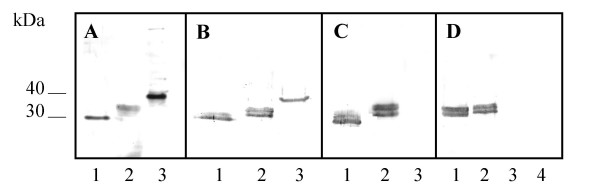
Western blots of 10% slab gels loaded with Hwp1 antigens of C. albicans stained with silver stain (panel A), an anti-Myc monoclonal antibody (panel B, lane 1), an anti-HSV monoclonal antibody (panel B, lanes 2 and 3), a polyclonal antiserum against the purified recombinant N-Hwp1 fragment (panel C) and human sera (panel D). Gels in panels A-C were loaded with rHwp1N13KV-c~myc (lane 1), N-Hwp1 (lane 2) and int-Hwp (lane 3). Panel D shows the reactivity of N-Hwp1 with sera from two patients with invasive candidiasis (lanes 1 and 2) and from two patients without invasive candidiasis (lanes 3 and 4). Molecular masses (in kDa) of standard proteins are listed to the left of the gels.